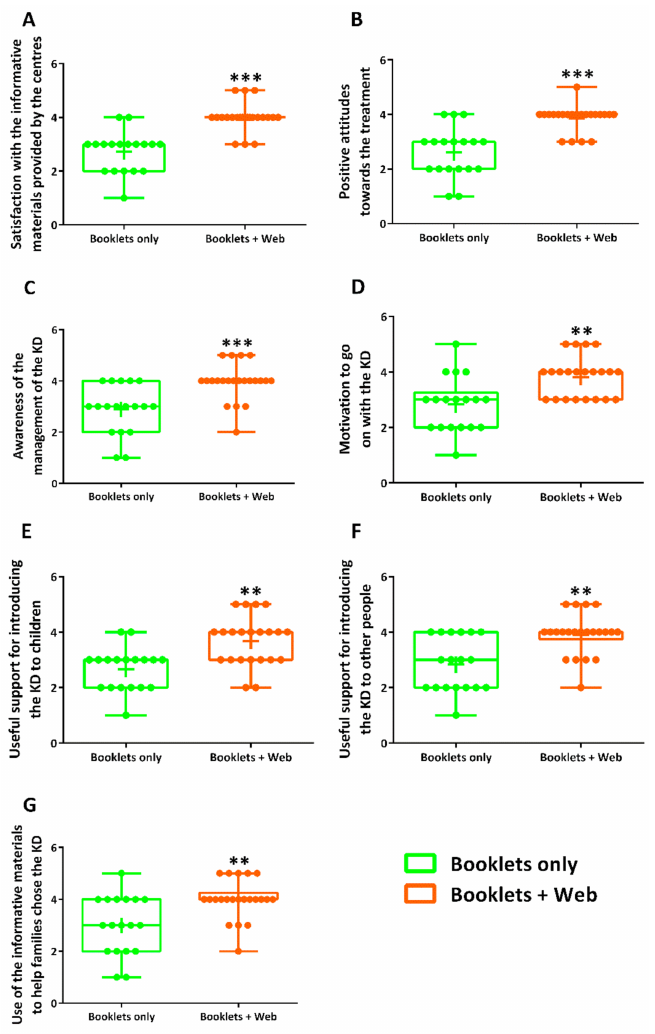
Figure 4. Comparison between channels of communication through which caregivers received information about the ketogenic diet. The group called “Booklets only” included caregivers with access only to booklets/leaflets, whereas the group known as “Booklets + Web” consisted of caregivers with access also to the KetApp and videos. Specifically, the two groups were compared in relation to ( A ) the satisfaction about the level of information of the materials provided by the centres; ( B ) the change in the attitude on the treatment after reading the informative materials; ( C ) the awareness of the management of the ketogenic diet; ( D ) the motivation to go on with the ketogenic diet; ( E , F ) the usefulness of the informative materials to explain the diet to children and other people involved in the dietary management; ( G ) the usefulness of the informative materials in motivating other families to choose the ketogenic diet (** p < 0.01, *** p < 0.001; Mann–Whitney test). The whiskers of the boxes represent the minimum and maximum values. In addition to the values of median, the mean is also represented by a +. KD, Ketogenic